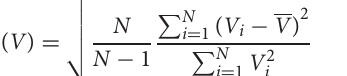
of α , H , ADC, generalized FA (gFA)( α ), gFA( H ), and gFA(ADC) in the left and right hippocampus were